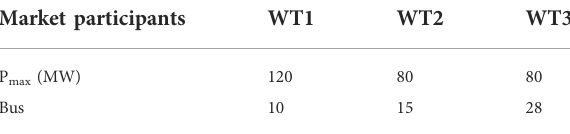
TABLE A3 Parameter settings of wind